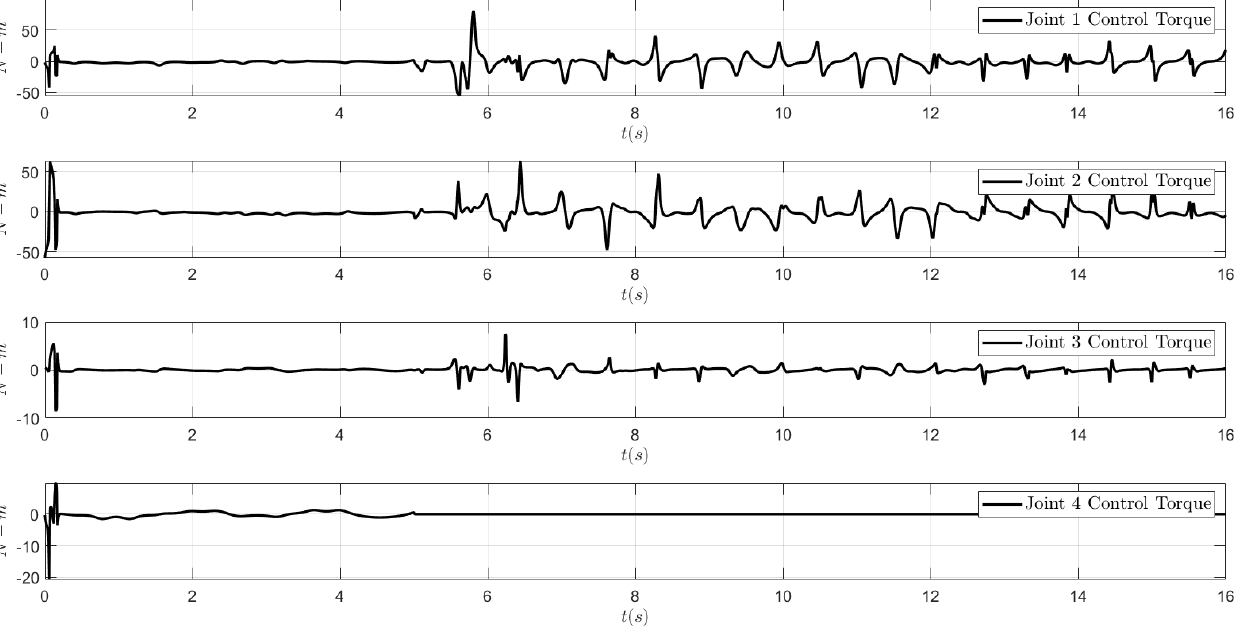
Figure 8. Control signal with adaptive chaos